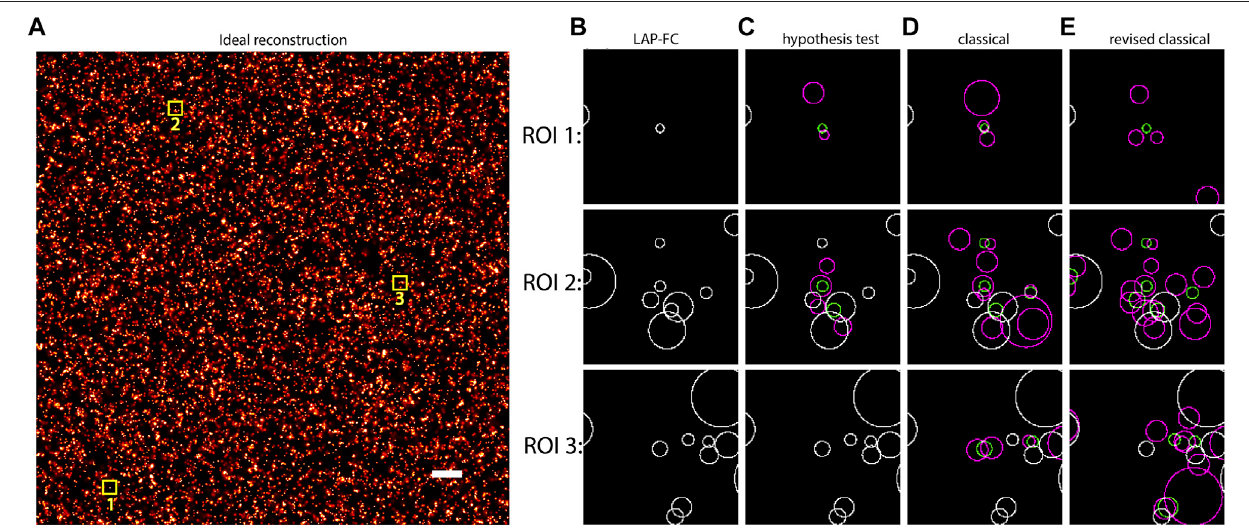
FIGURE 1 | Uniformly distributed emitters with initial density ρ 0 (cid:2) 10 emitter/pixel 2 , k on (cid:2) 0.005/frame, k off (cid:2) 0.5/frame, k bleach (cid:2) 0.2/frame, p miss (cid:2) 0.01, photon emissionrateof1,000photons/frame,additionalGaussiannoisewith σ (cid:2) 0.05pixels,and10,000totalframes. (A) “ Ideal ” frame-connectionsolution,scalebar (cid:2) 2pixels. (B) – (E) Results for the three sub-ROIs marked with yellow squares in (A) using (B) LAP-FC with a maximum pre-clustering frame gap of fi ve frames and a maximum separationof5timesthelocalizationerror; (C) thehypothesistestalgorithmwithamaximumframegapof fi veframes,amaximumseparationof1pixel,andalevel- of-signi fi cance of 0.05; (D) the classical algorithm with a maximum frame gap of 1 frame and a maximum separation of 0.2 pixels; and (E) the revised classical algorithm with a maximum frame gap of fi ve frames and a maximum separation of 2 times the localization error. The circles in (B) – (E) are centered at the localization position with radii equal to the localization error. Green circles represent localizations from the ideal results from (A) . Magenta circles represent the results of the frame-connection algorithm. White circles correspond to frame-connection results matching the ideal results.